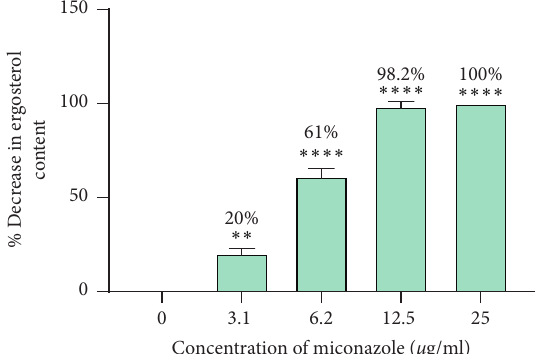
Figure 11: The effects of miconazole on cells exposed to miconazole. Ergosterol content decreased as the concentration of miconazole was increased. A percentage decrease in ergosterol of 100% was observed at 25 μ g/ml of miconazole. Data were analysed by one-way ANOVA. The data represent the mean of two experiments, and the standard deviation was shown by the error bars. ∗∗∗∗ p < 0 . 0001 and ∗∗ p < 0 . 01.